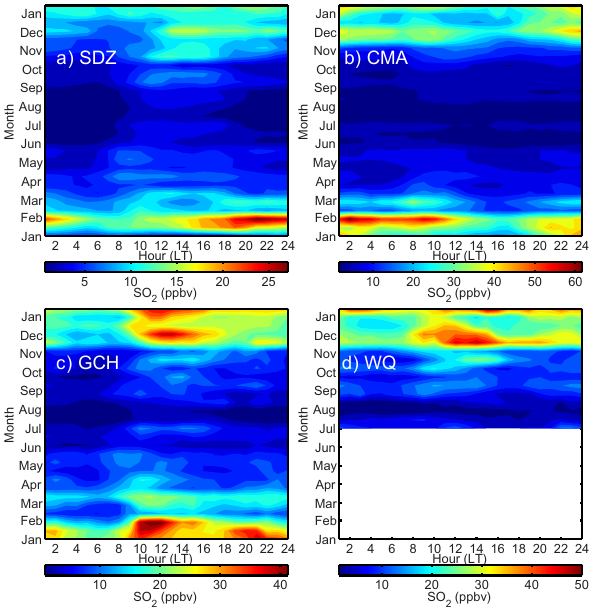
Figure 2. Diurnal and seasonal variation of SO 2 concentrations at the (a) Shangdianzi, (b) China Meteorological Administration, (c) Gucheng and (d) Wuqing